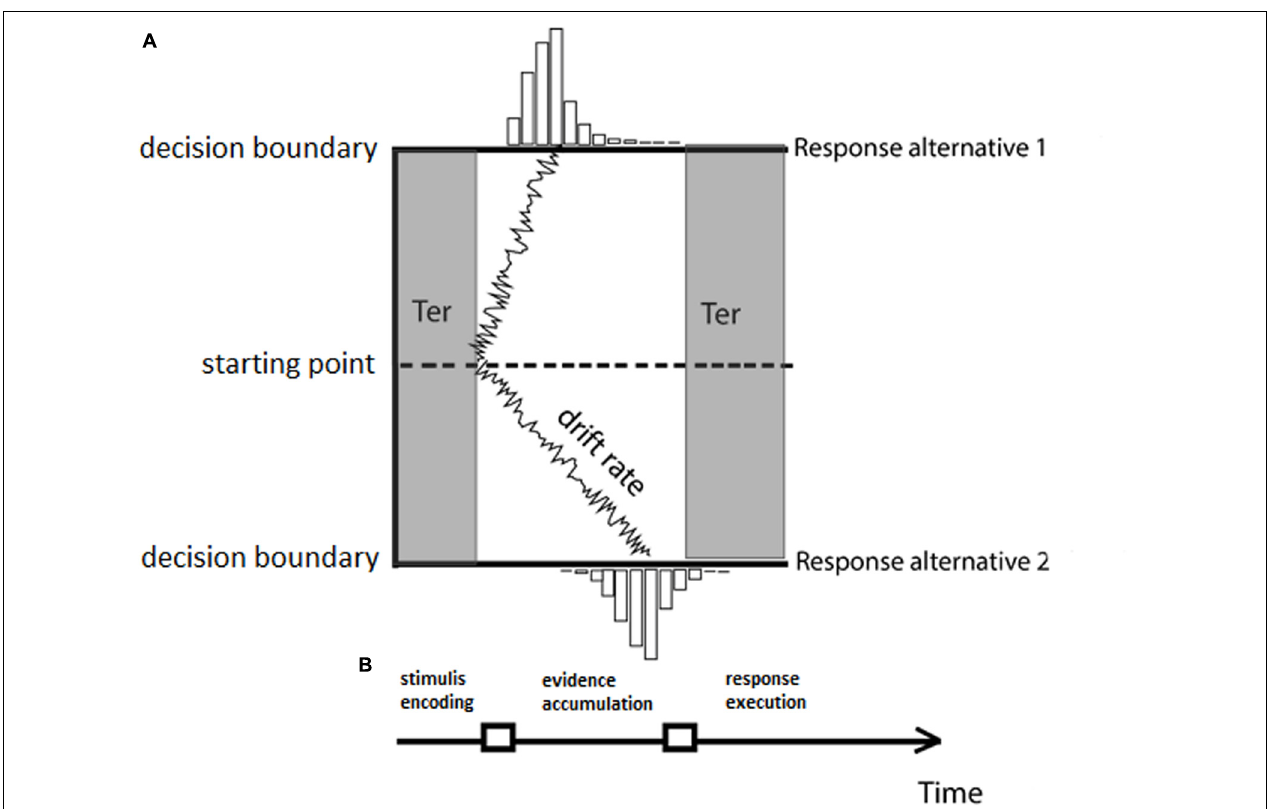
FIGURE 1 | (A) The drift-diffusion model (DDM) with the four parameters: drift rate ( v ), boundary separation ( A ), starting point ( z ), and non-decision component ( T er ). (B) Stages of processing characterized by the DDM model. Different stages of processing are highlighted by the shadings in panel (A) indicating the mapping of the DDM components to the processing